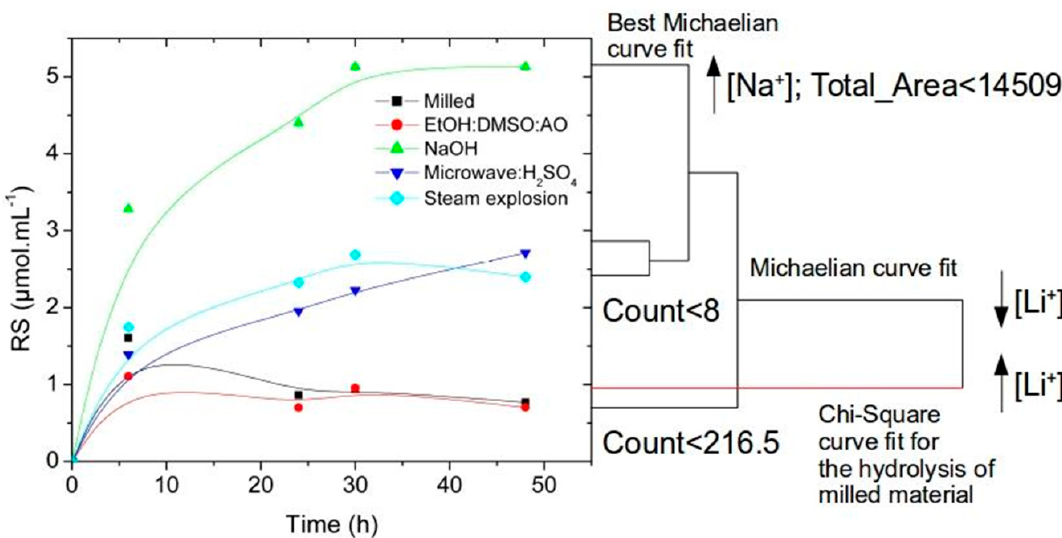
Figure 3. Time-dependent release of reducing sugars during the enzymatic hydrolysis of sugarcane bagasse. Generalized additive model (GAM) curves for reducing sugars (RS) released and the similarity analysis among enzyme cocktail activities were shown with the major traits related to the structural differences among each pretreatment using Mixture Discriminant Analysis (MDA) at p =